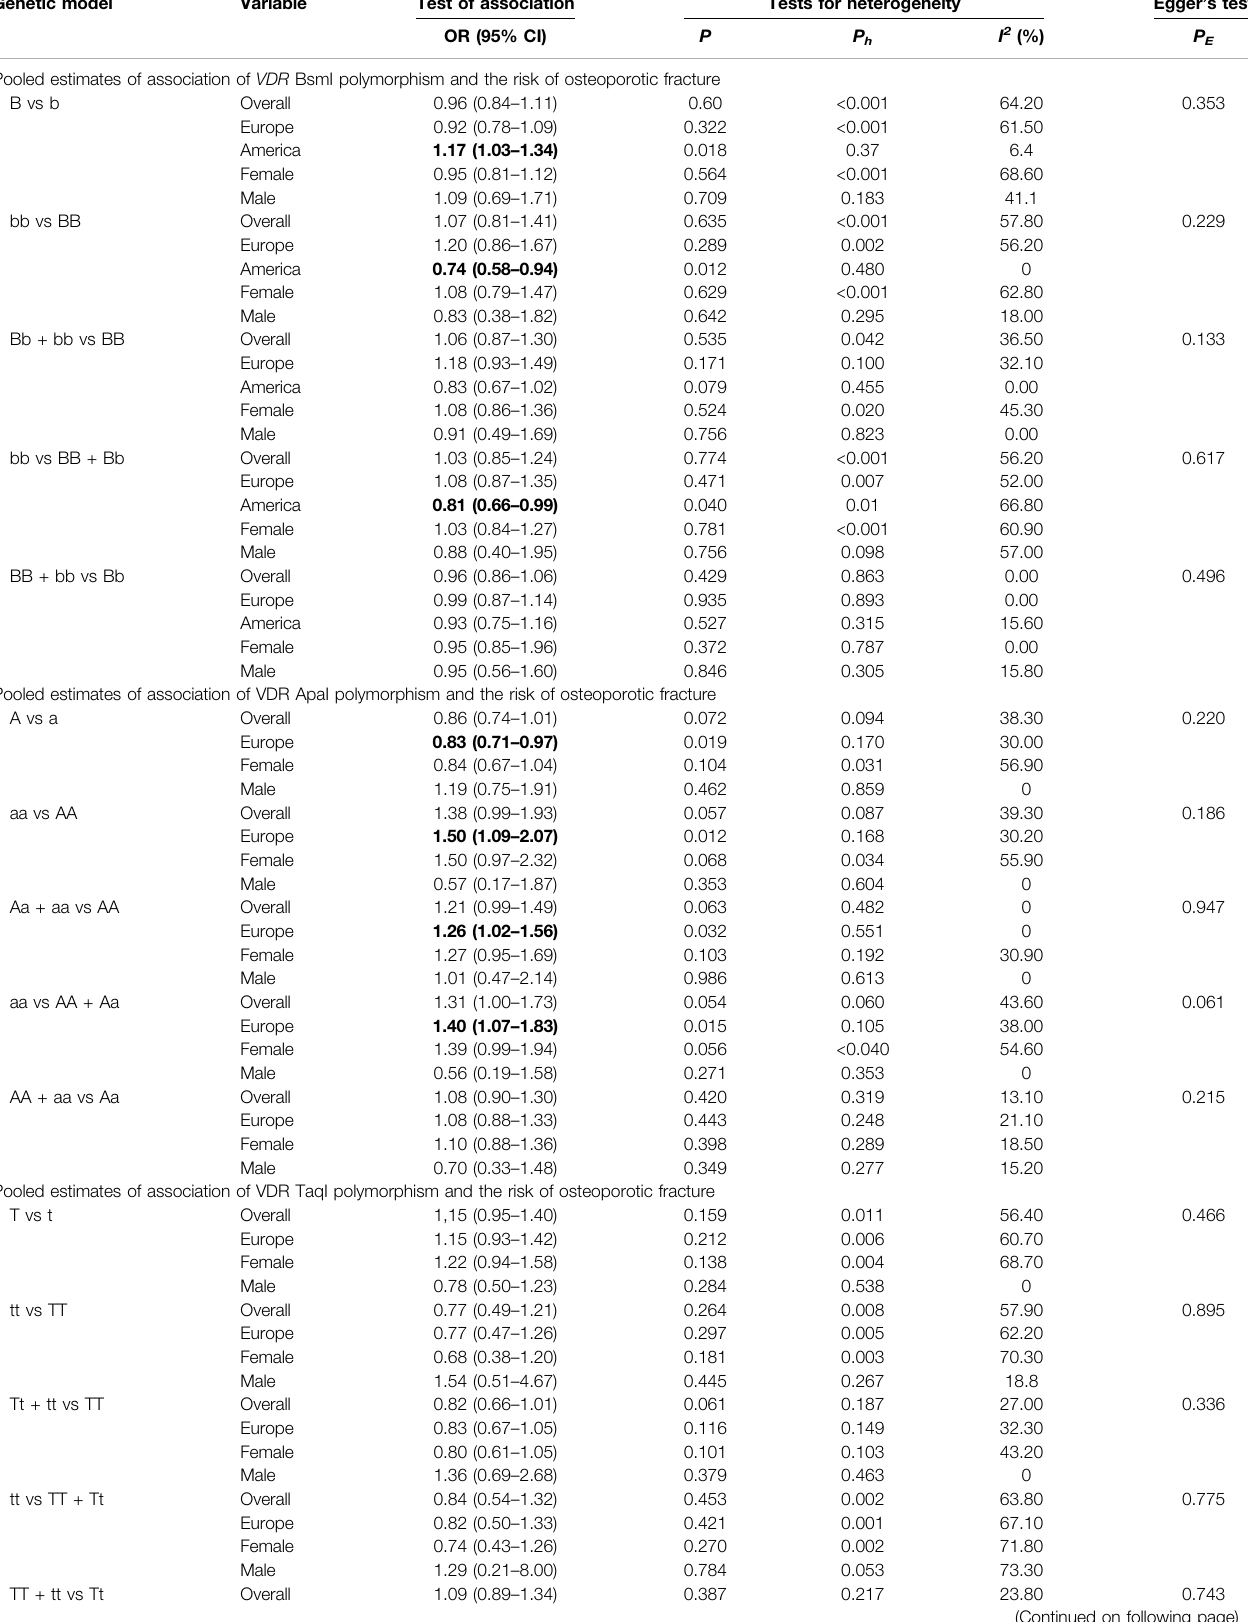
TABLE 12 | Data related to the HWD article were not